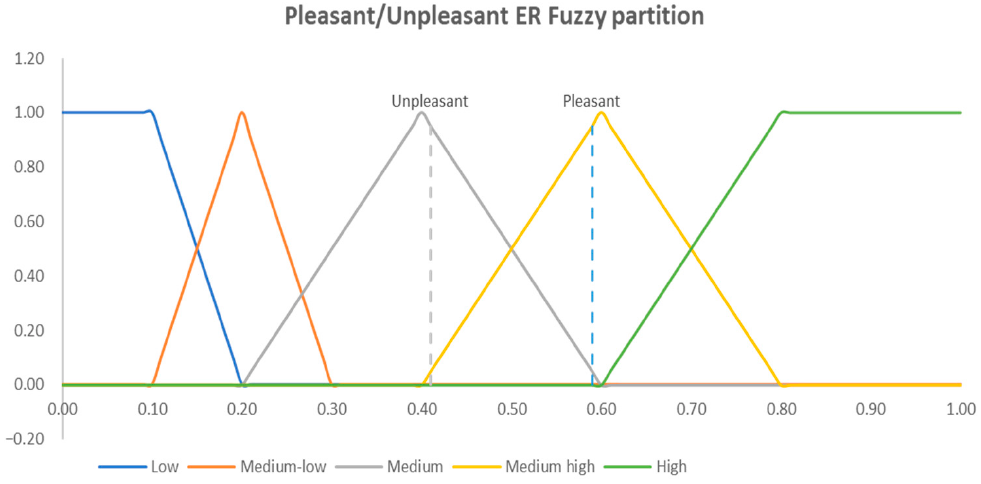
Figure 1. Example of Pleasant/Unpleasant ER fuzzy partition.